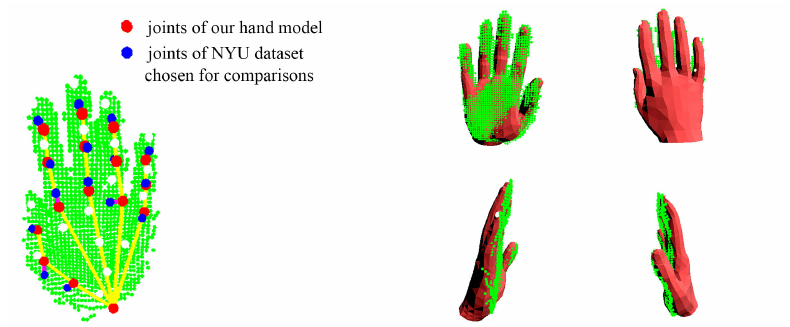
Figure 22. The subset of 15 joints chosen from the NYU annotation and the joints of our hand model in a simple hand pose. In this pose, the mean error of joints is 8.30